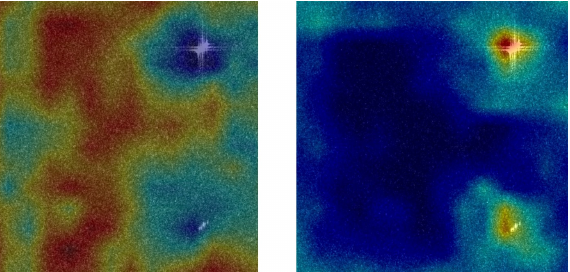
Figure 6. Comparison of thermal diagrams before and after refinement.